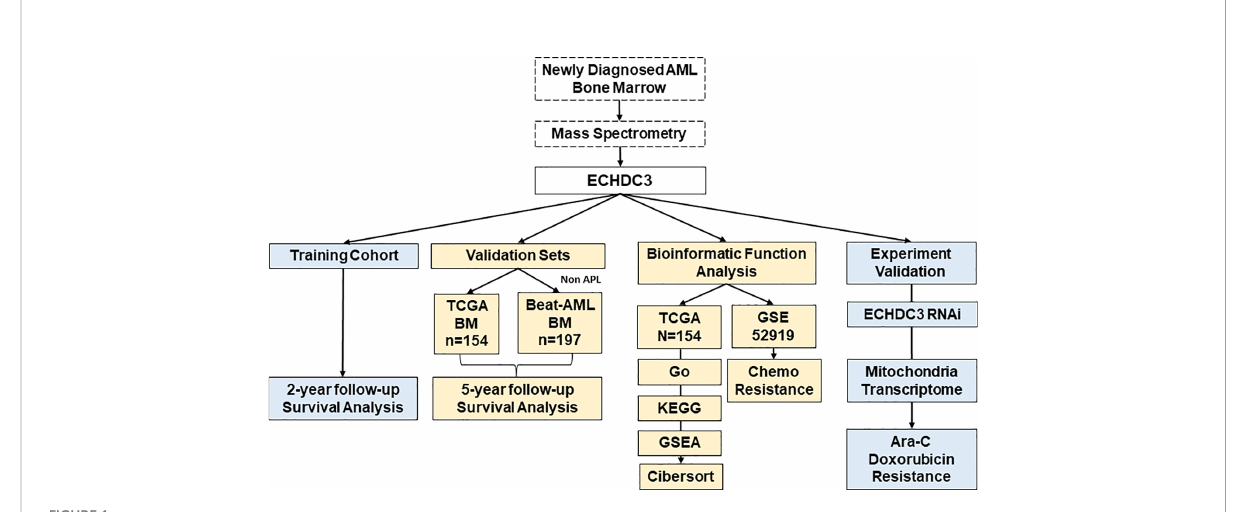
FIGURE 1 The fl ow chart of the study design and